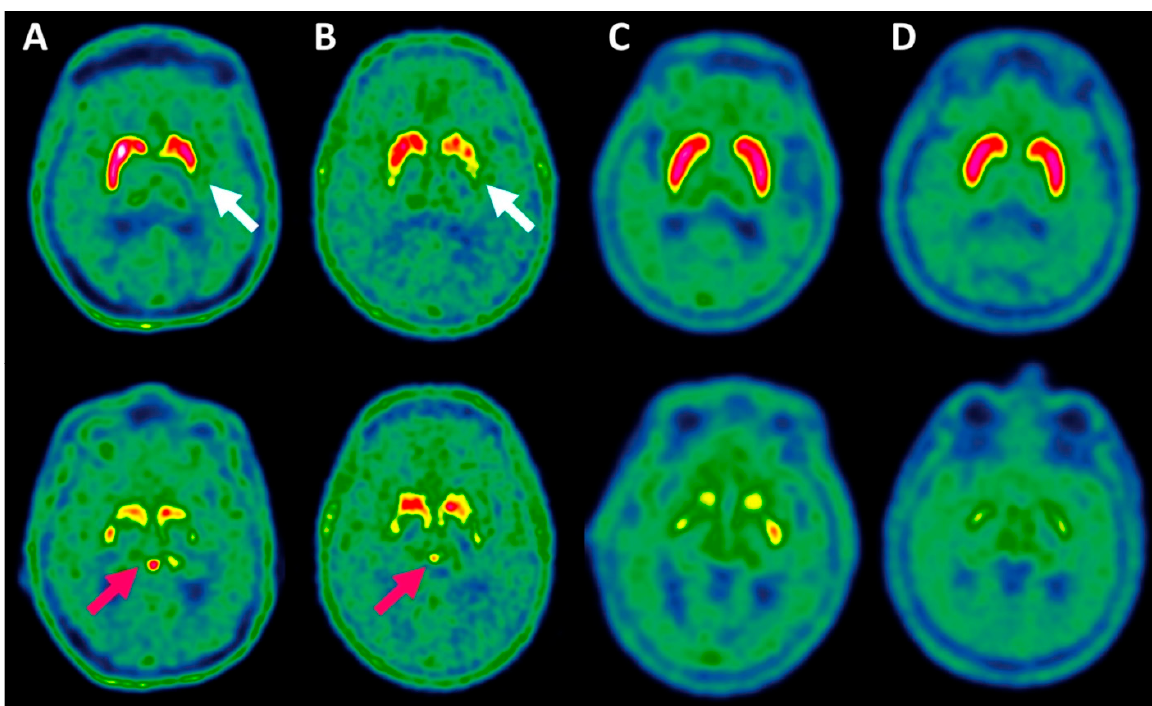
Figure 1. Visual assessment of 18 F-DOPA uptake in the basal ganglia (upper row) and in the pineal body (lower row) in patients with nigrostriatal dysfunction (NSD) ( A , B ) and in patients with non- NSD conditions ( C , D ). In NSD patients, notice the asymmetric decreased uptake pattern in the basal ganglia (white arrows) with concurrent increased pineal body uptake compared to the background (pink arrows). Non-NSD patients demonstrated normal 18 F-DOPA uptake pattern in the basal ganglia with virtually absent uptake in the pineal body.